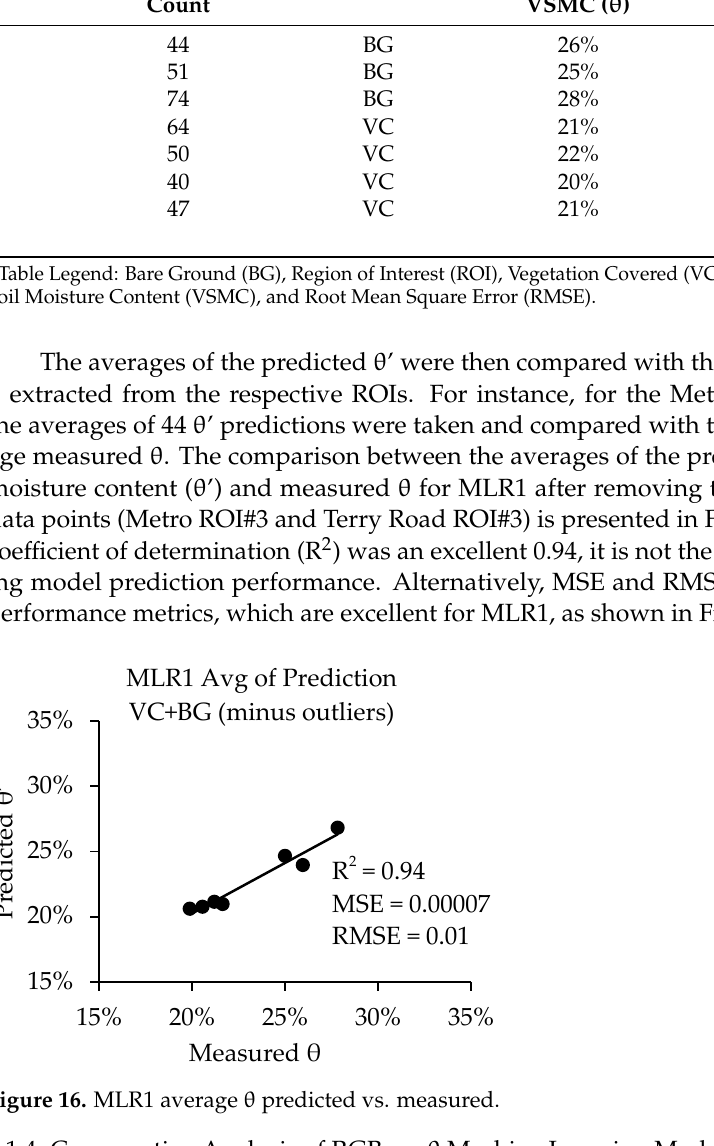
Figure 16. MLR1 average θ predicted vs. measured.